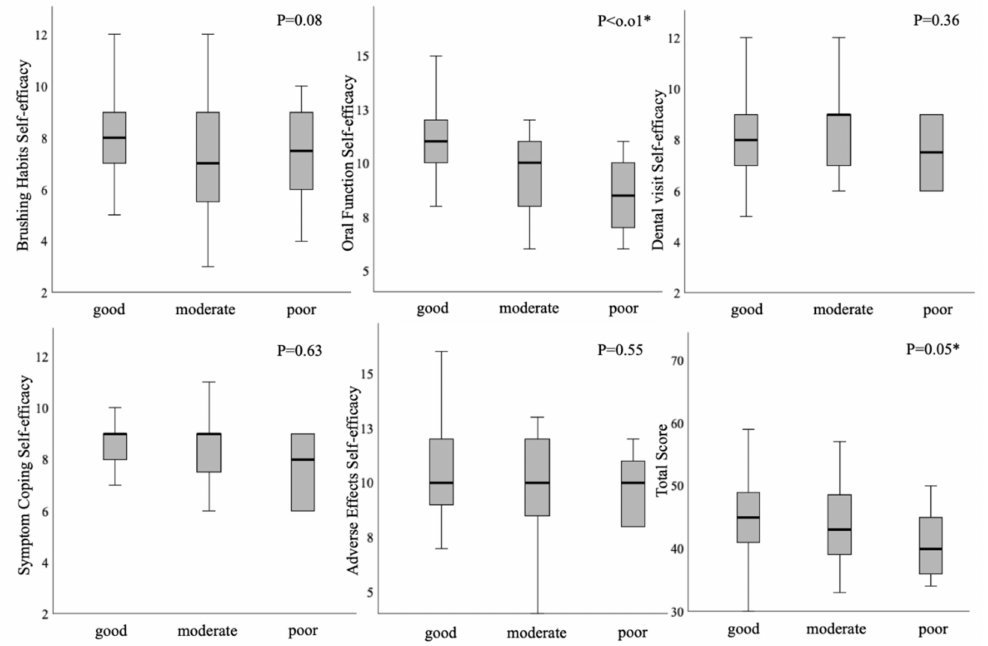
Figure 2. Stepwise correlation between the Oral Health-related Self-E ffi cacy Scale for Patients with Cancer (OSEC) and the Functional Oral Intake Scale (FOIS) using the Jonckheere–Terpstra